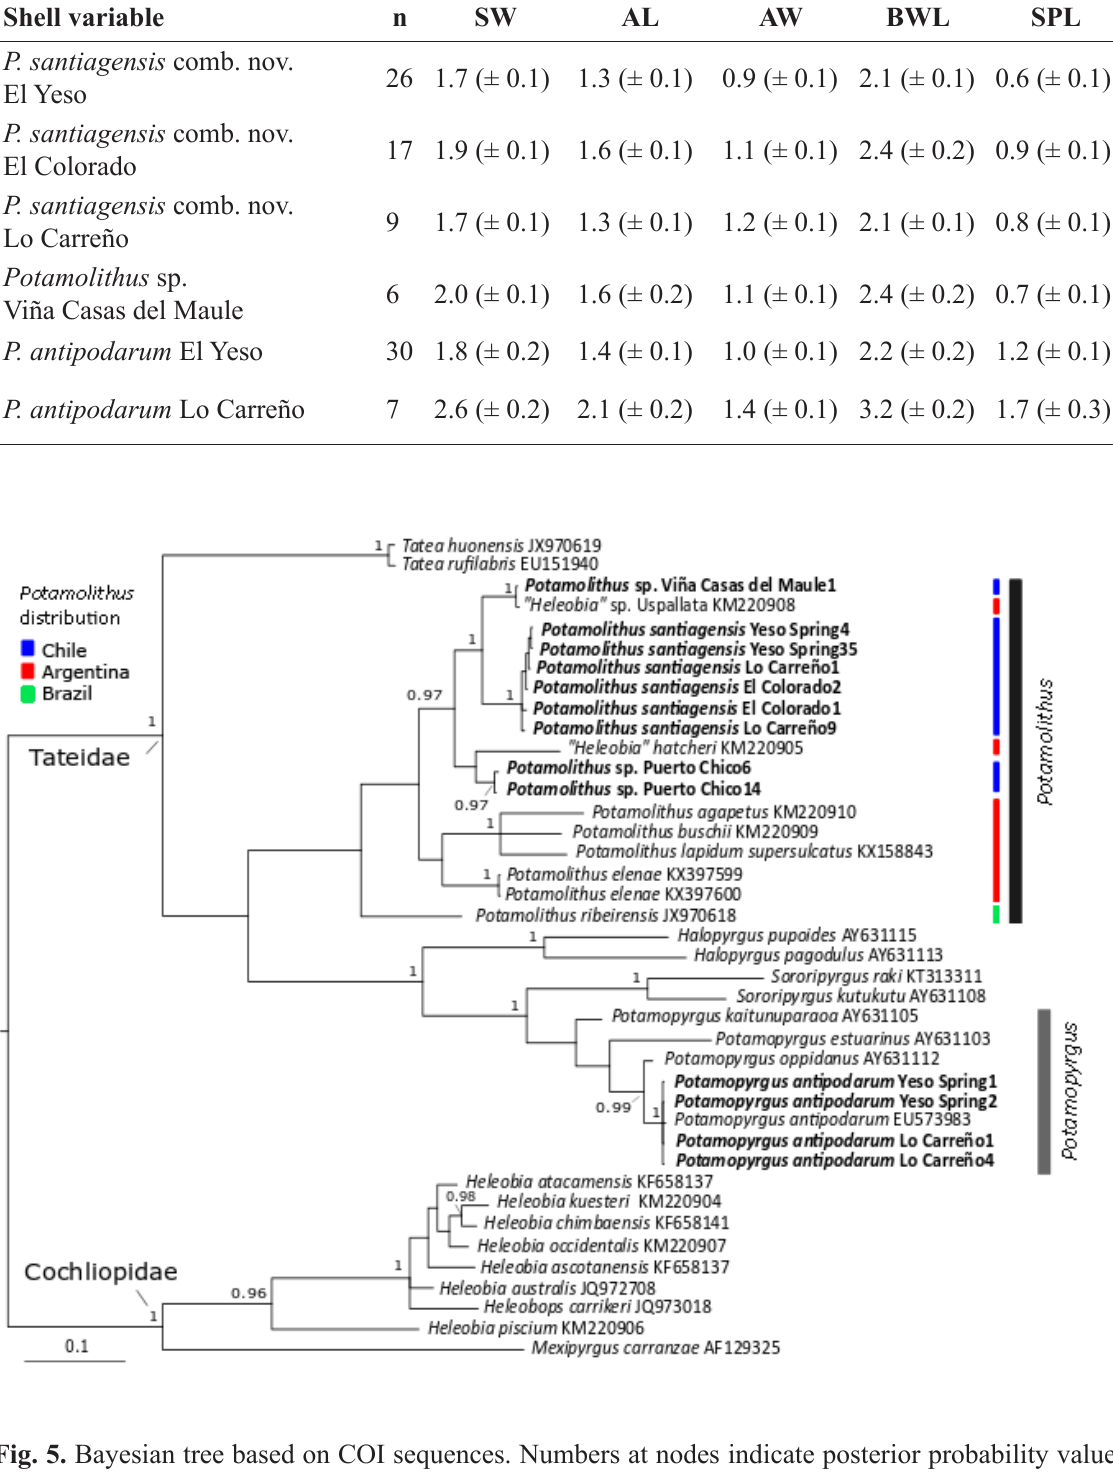
Fig. 5. Bayesian tree based on COI sequences. Numbers at nodes indicate posterior probability values (only given if ≥ 0.95). Names in bold refer to new sequences reported in this paper. Numbers following taxa refer to GenBank